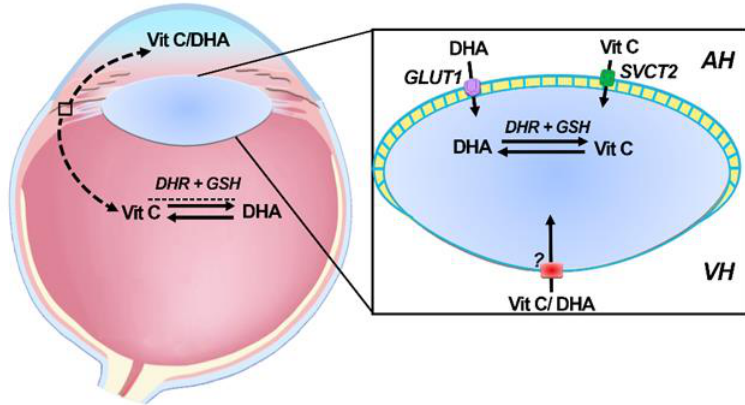
Figure 5. Vitamin C uptake pathways in the lens. In human lenses, SVCT2 localized to the lens epithelium is used to accumulate vitamin C from the aqueous humor (AH), while GLUT1 expressed in the epithelium and cortical fiber cells can function to uptake DHA from the aqueous humor. Whether vitamin C and/or DHA in the vitreous humor (VH) can be taken up from the posterior side of the lens is unknown.